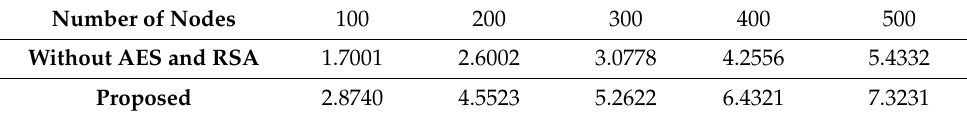
Table 1. Simulation parameters.